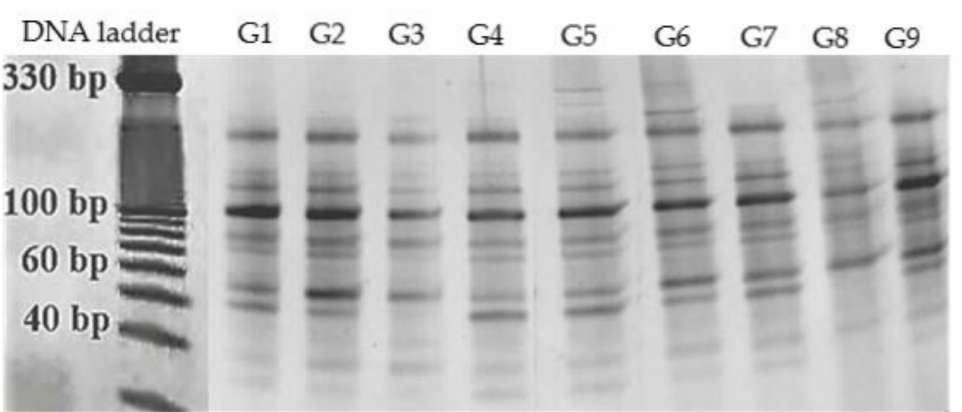
Figure 1. PCR amplification profile generated with miRNA-based primer pair gb-miR160F / gb-miR75R across 9 genotypes of Ginkgo biloba : G1—Nov á Ves nad Žitavou, G2—Topol’ˇcianky,